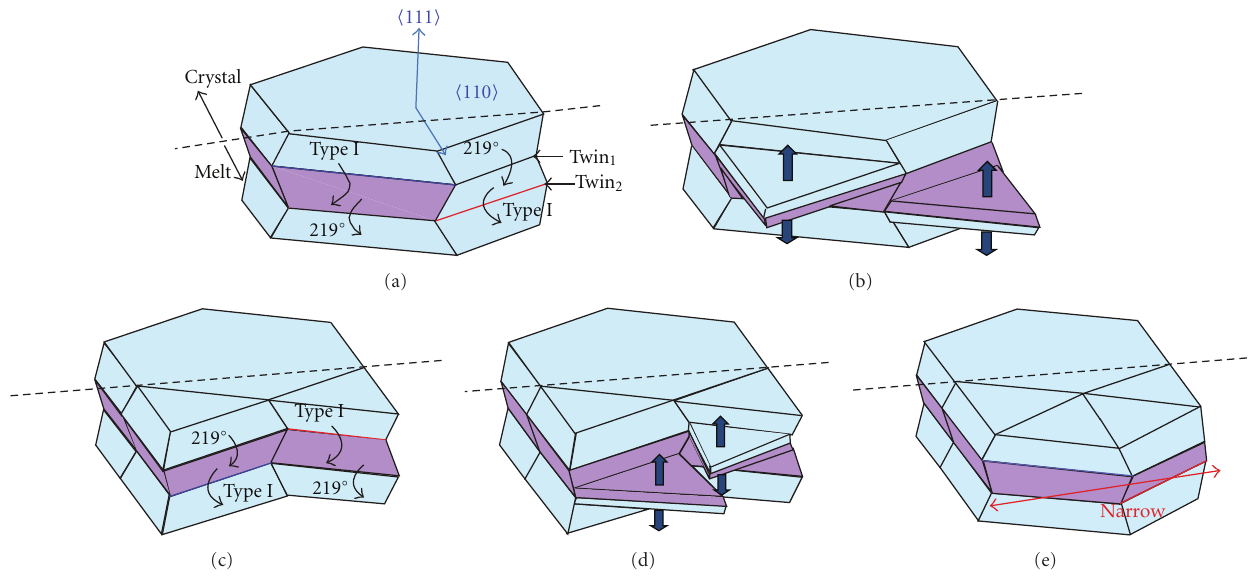
Figure 18: Schematic images of growth of Si (cid:4) 110 (cid:5) dendrite [73]. (a) Equilibrium form of crystal with two twins, which is similar to that shown in Figure 17(a). It is considered that the crystal grows only in the (cid:4) 110 (cid:5) direction. Reentrant type I corners appear at both twin 1 and twin 2 . This is markedly di ff erent from the growth of the (cid:4) 112 (cid:5) dendrite. (b) Triangular corners are formed owing to the rapid growth at both twins. (c) Crystal growth can continue on the { 111 } flat surface. When triangular crystals propagate across another twin, two new type I corners are formed at both twins. (d) Rapid growth occurs at the two type I corners again, and a triangular corner is formed. (e) After the propagation of the triangular crystals, type I corners are formed at both twins. A faceted dendrite continues to grow along the (cid:4) 110 (cid:5) direction by repeating the process from (b) to (e). The tip of the (cid:4) 110 (cid:5) dendrite remains narrow during crystal growth.